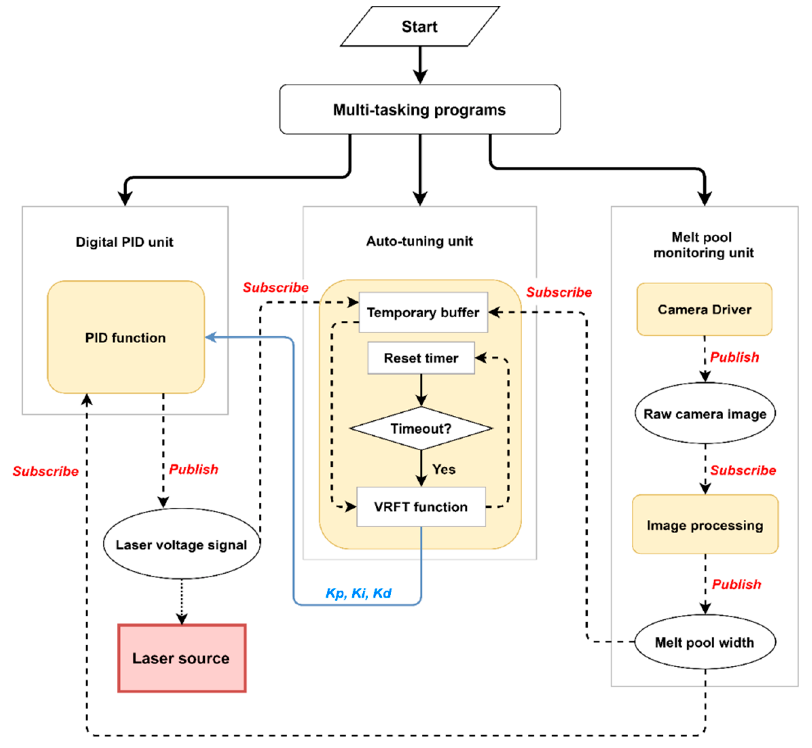
Figure 3. The multitasking architecture of the proposed data-driven adaptive controller.